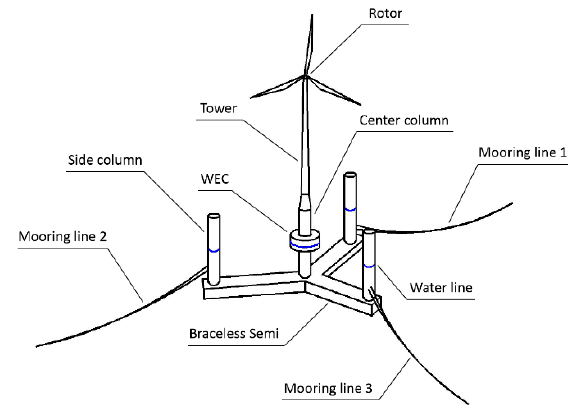
Figure 1. Conceptual sketch of the combined structure.